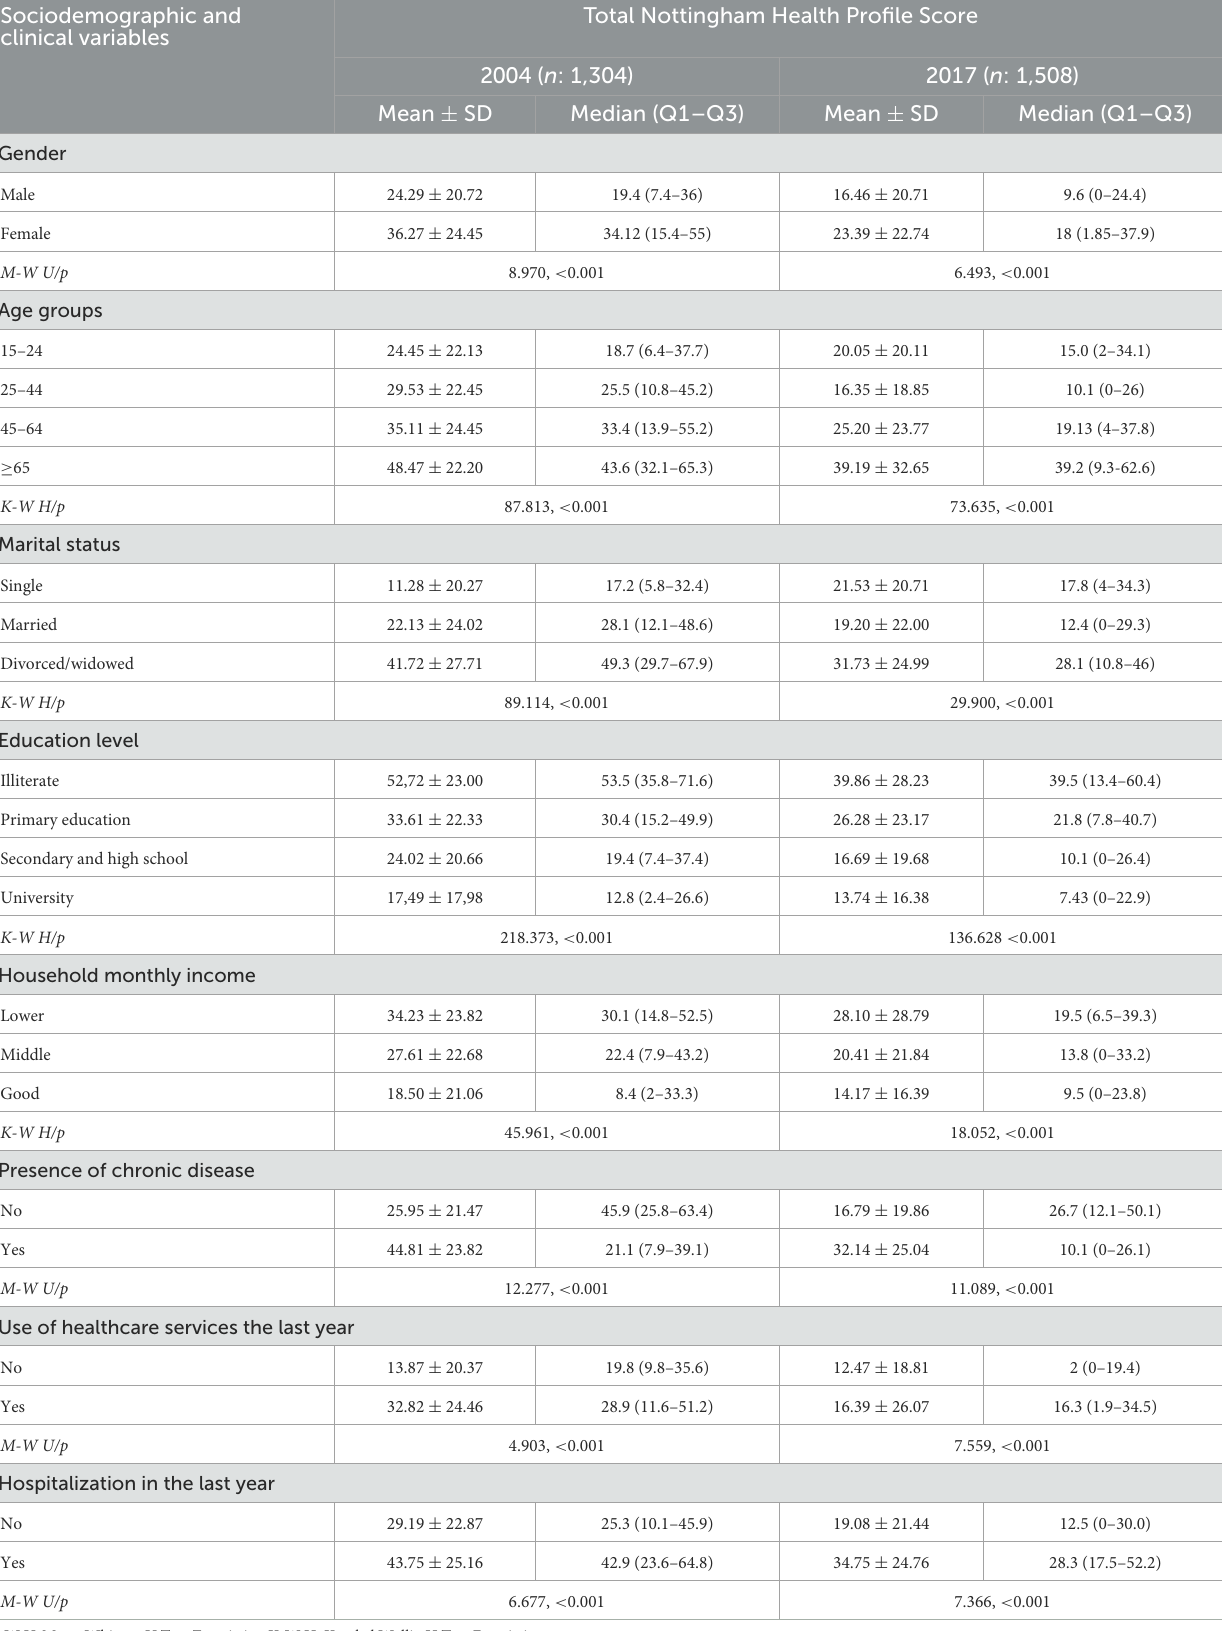
TABLE 4 Distribution of total Nottingham Health Profile Scores according to sociodemographic and clinical variables in 2004 and 2017. Sociodemographic and clinical